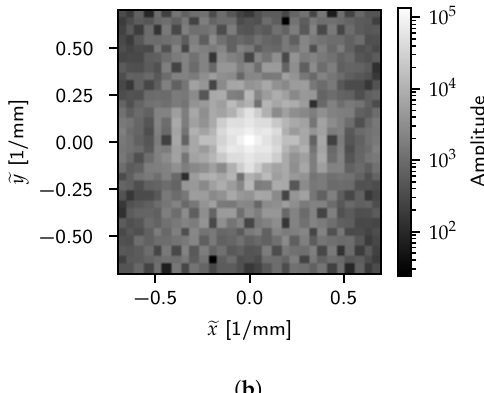
Figure 17. FFT of density for the cylindrical case over ( a ) the total frequency domain and ( b ) a low-frequency